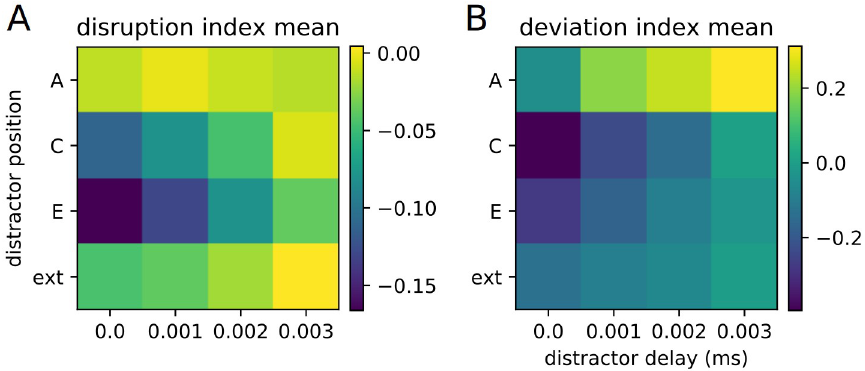
Fig 18. Disruption and deviance index arrays. An array of disruption and deviance index values for each experimental